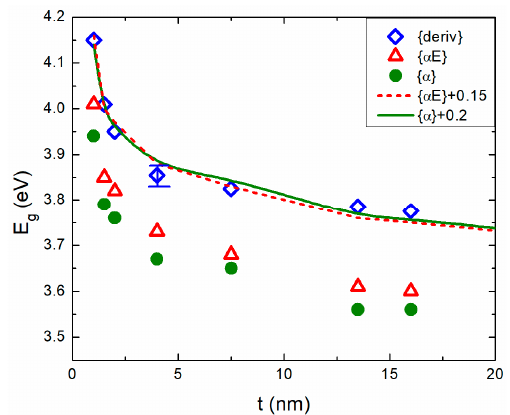
Figure 5. All features of absorbance spectra such as the onset of E g determined by the Tauc plots and the maximum of absorbance after the onset determined by the derivative maximum, coincide.